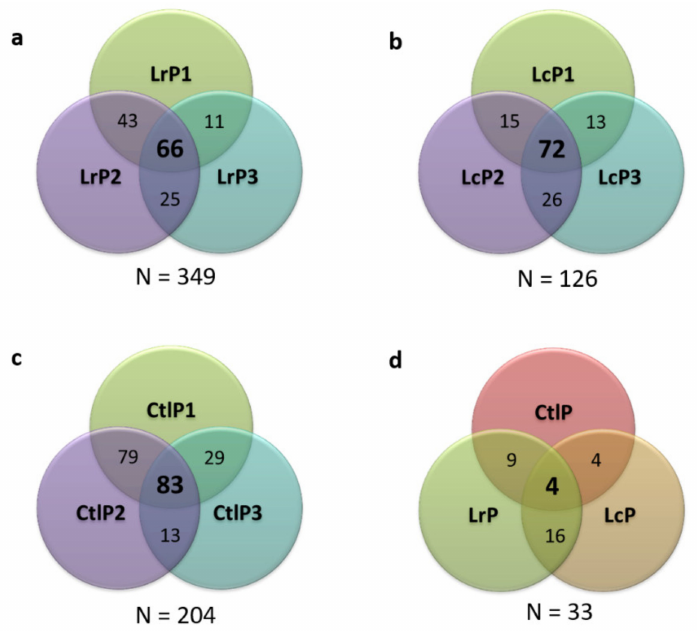
Figure 4. Venn diagrams showing the distribution of the identified peptides in the three biolog- ical replicates of each condition: ( a ) LrP, ( b ) LcP, ( c ) CtlP, and ( d ) comparing the three different tested